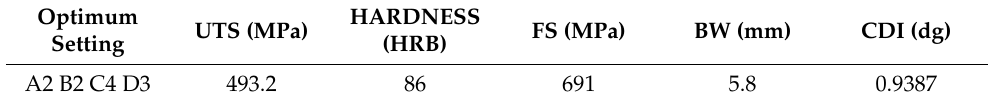
Table 28. The optimum parametric setting.